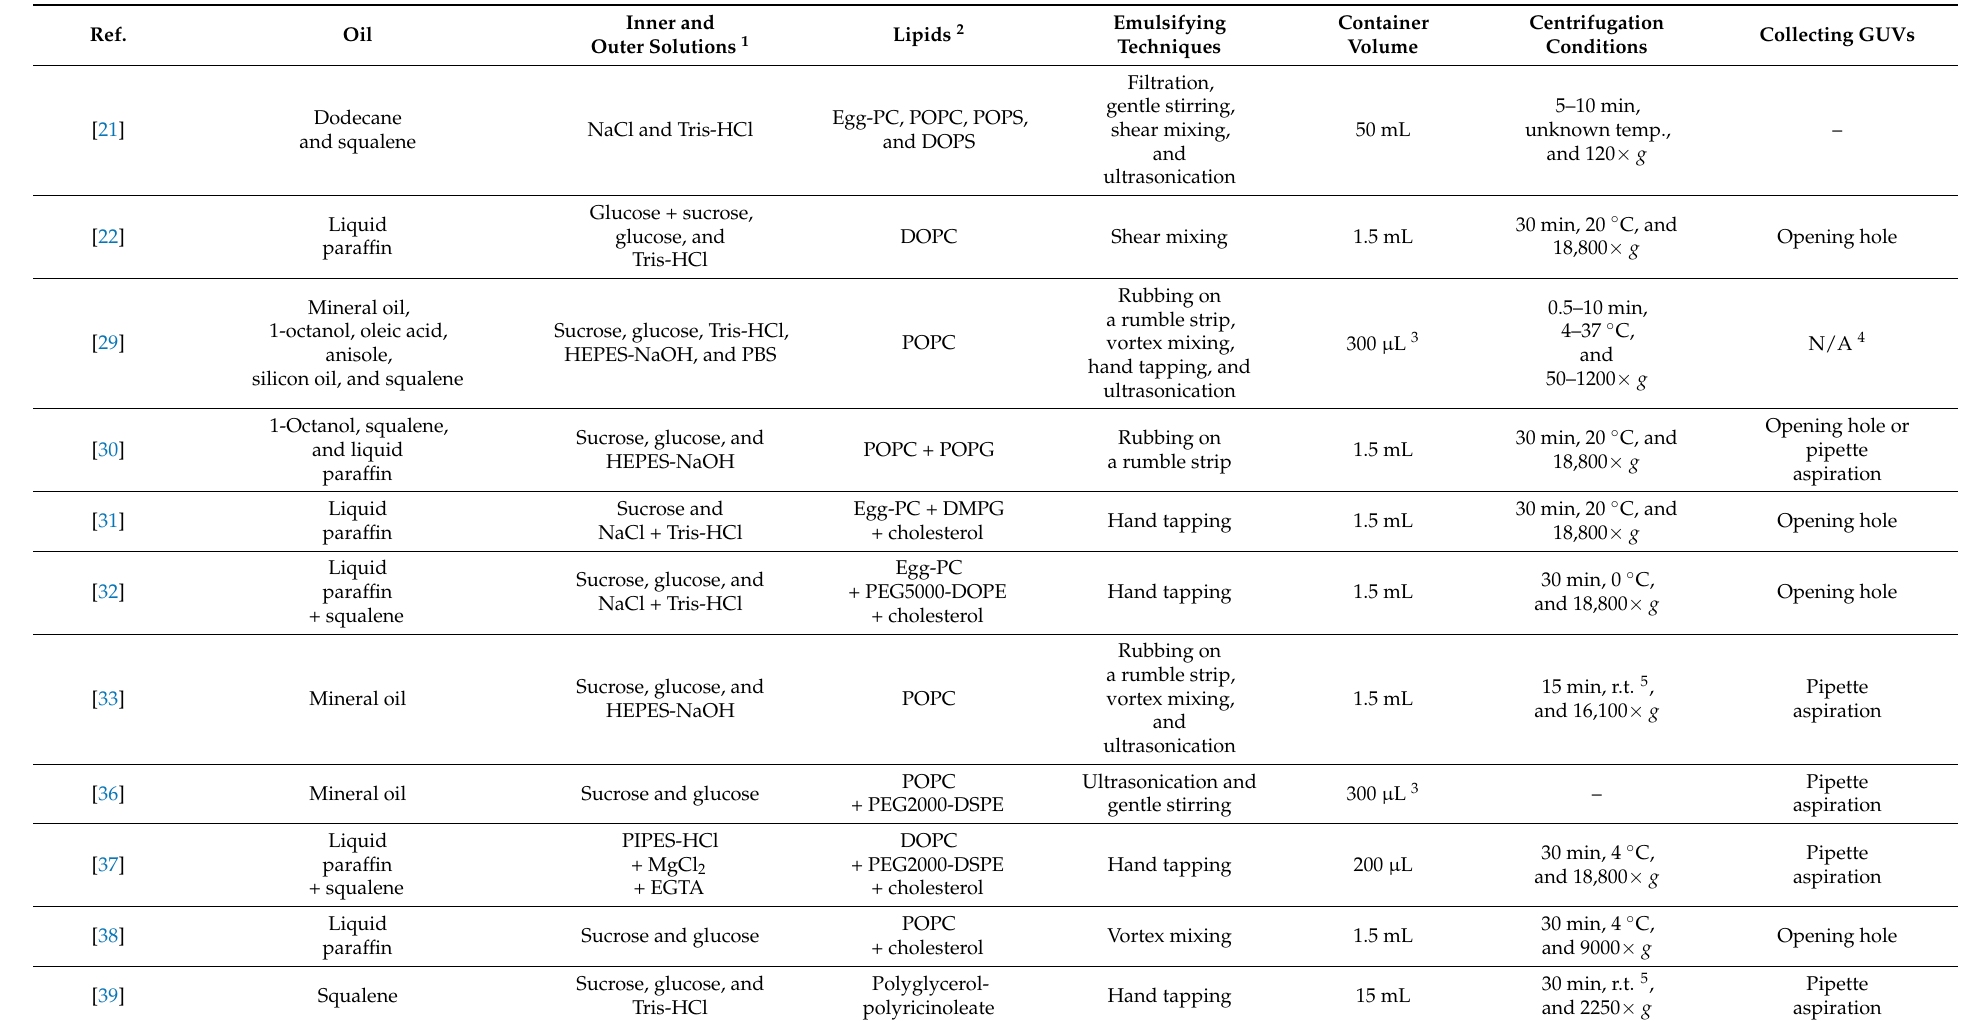
Table 1. Studies on the materials and experimental conditions used in the W/O emulsion template method protocol with centrifugation.